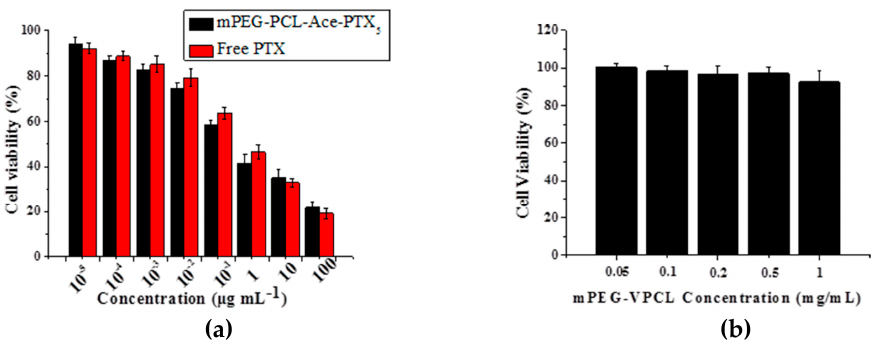
Figure 5. MTT assays of PTX mPEG-PCL-Ace-PTX 5 micelles ( a ) and Vinyl Ether-Functionalized mPEG-PCL ( b ) against MCF-7 cells. Data are presented as the average ± standard deviation ( n = 3).